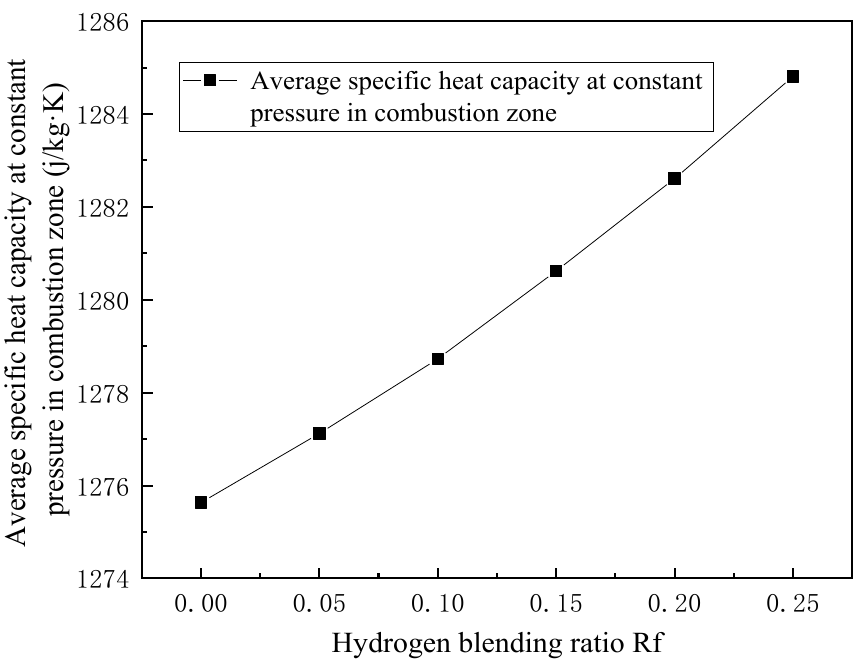
Figure 19. Average specific heat capacity at constant pressure in the combustion zone.